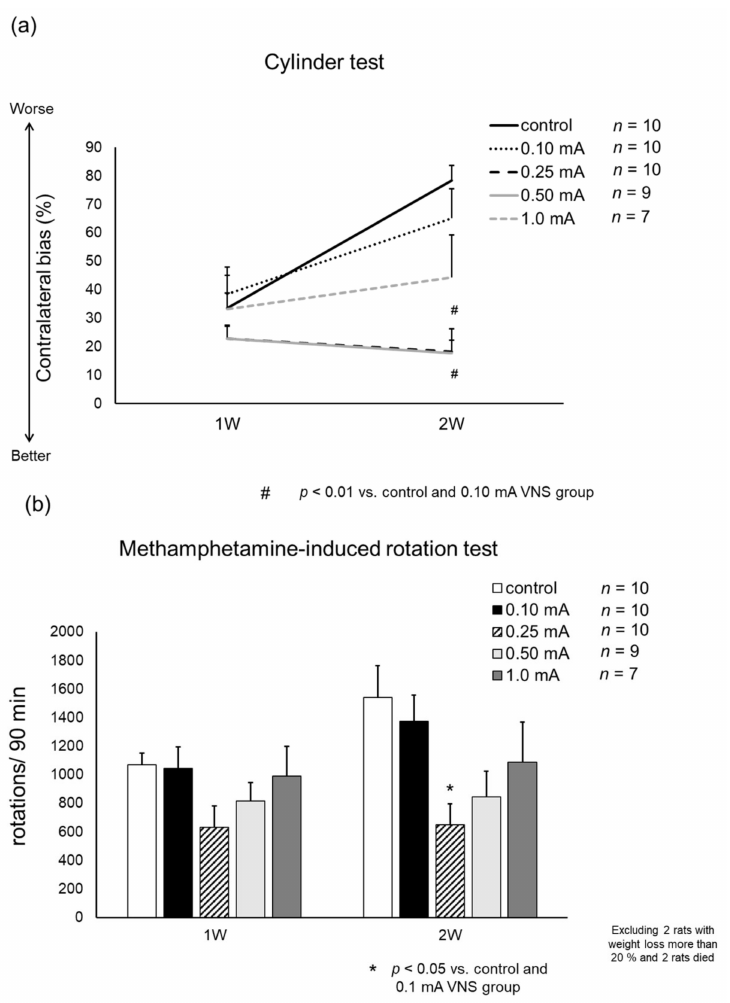
Figure 5. Results of behavioral tests. ( a ) The results of contralateral bias in the cylinder test. In the 0.25 mA and 0.5 mA VNS groups, the improvement of contralateral bias was observed at days 7 and 14 ( # p < 0.01 at day 14 vs. control and 0.1 mA VNS groups). ( b ) The number of methamphetamine- induced rotations per 90 min. The number of methamphetamine-induced rotations decreased in 0.25 mA and 0.5 mA VNS groups compared to the control group on days 7 and 14. The 0.25 mA VNS group significantly decreased rotation number at day 14 (* p < 0.05 vs. control and 0.1 mA VNS group). The data are presented as means ± SE and analyzed by one-way ANOVA and Turkey’s post hoc tests. n = 7–10